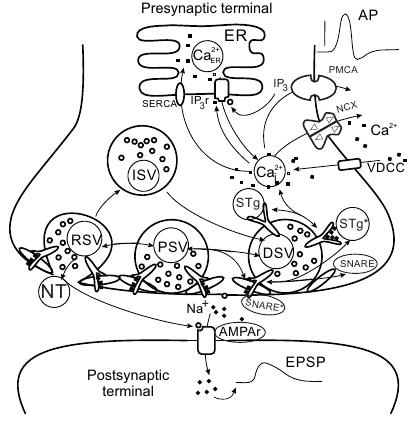
Figure 1. The scheme of synaptic